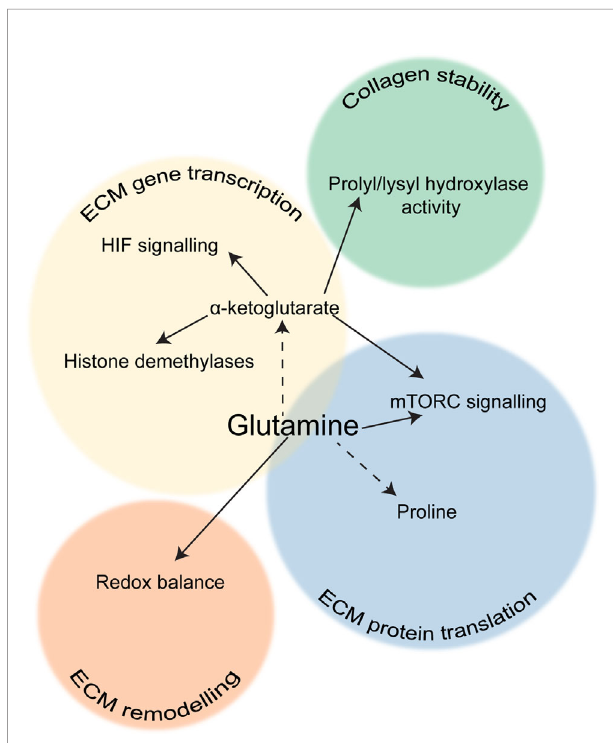
FIGURE 3 | The role of glutamine in ECM production. Scheme showing the different aspects of ECM production that are in fl uenced by glutamine metabolism in fi